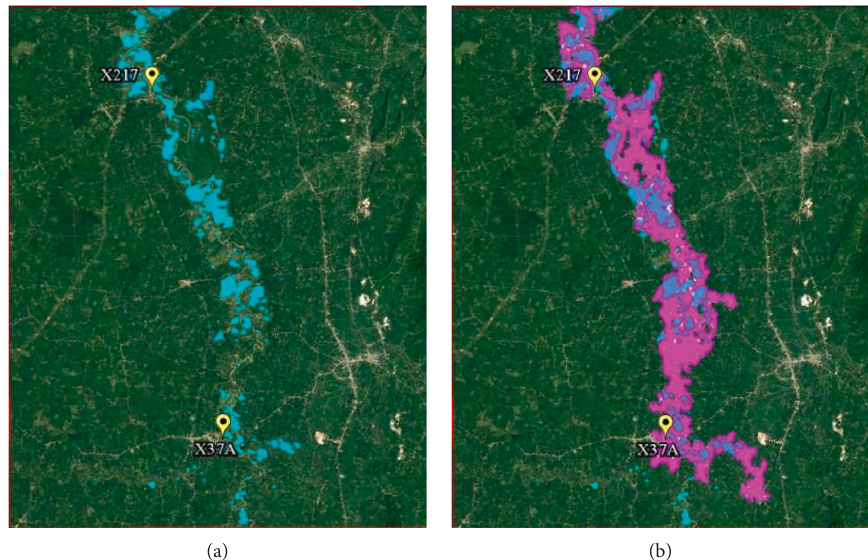
Figure 20: The simulation and real data of flooded area images on January 11, 2017. (a) The real data from satellite image on January 11, 2017. (b) The difference between the real data and the simulation result.